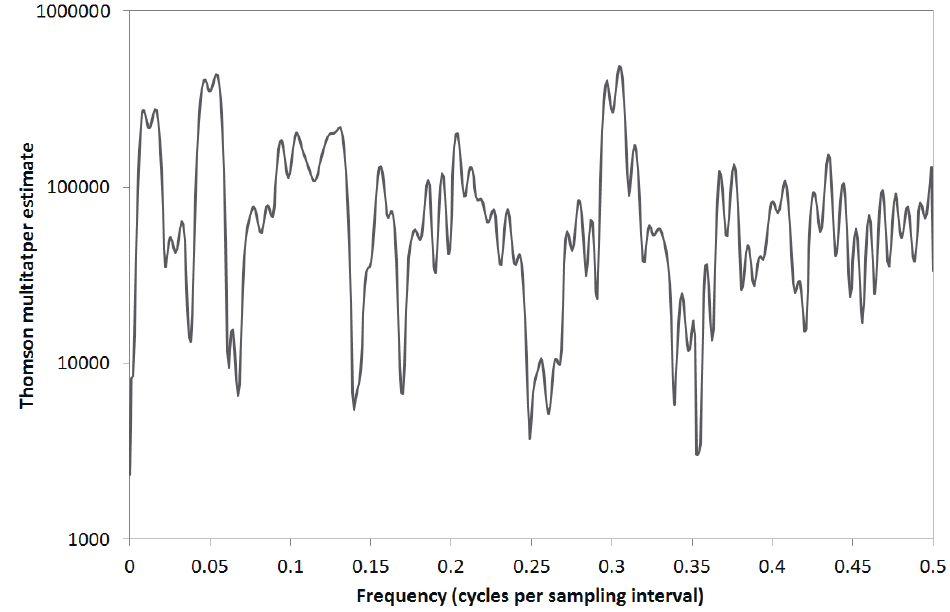
Figure 4. Power spectrum estimated by the Thomson multitaper method with 5